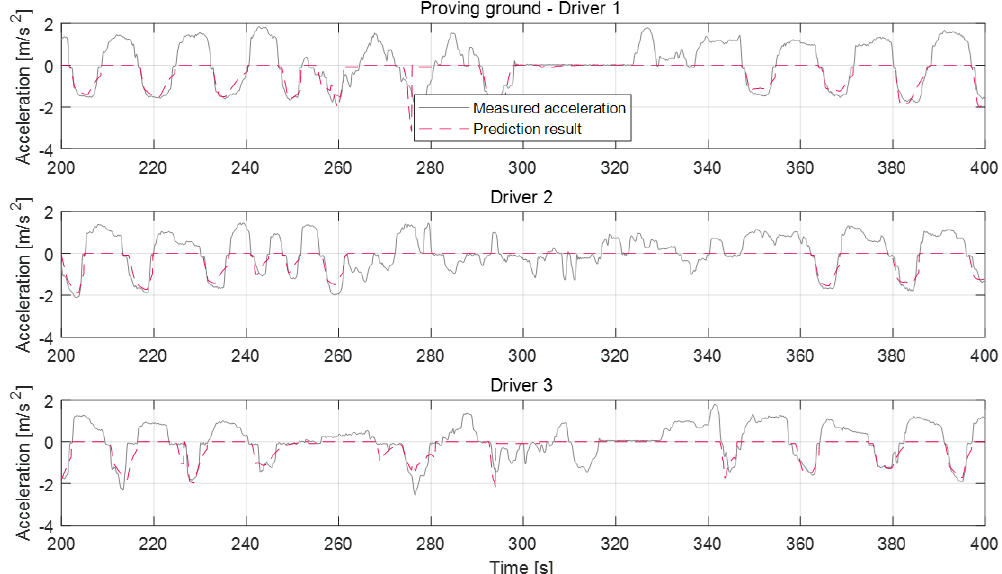
Figure 19. Deceleration prediction results in the dynamic deceleration condition on proving